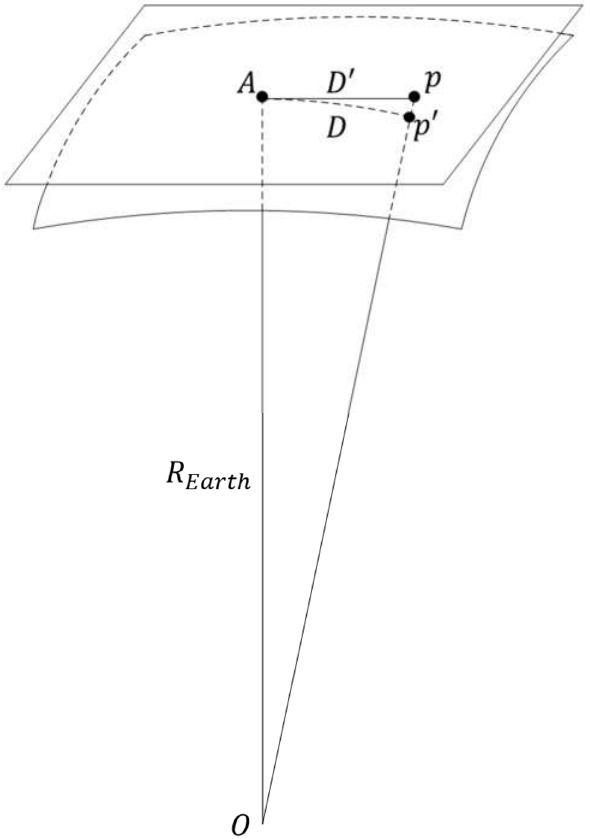
Figure 3 Schematic diagram of the elevation error caused by the curvature of the earth (pp’)